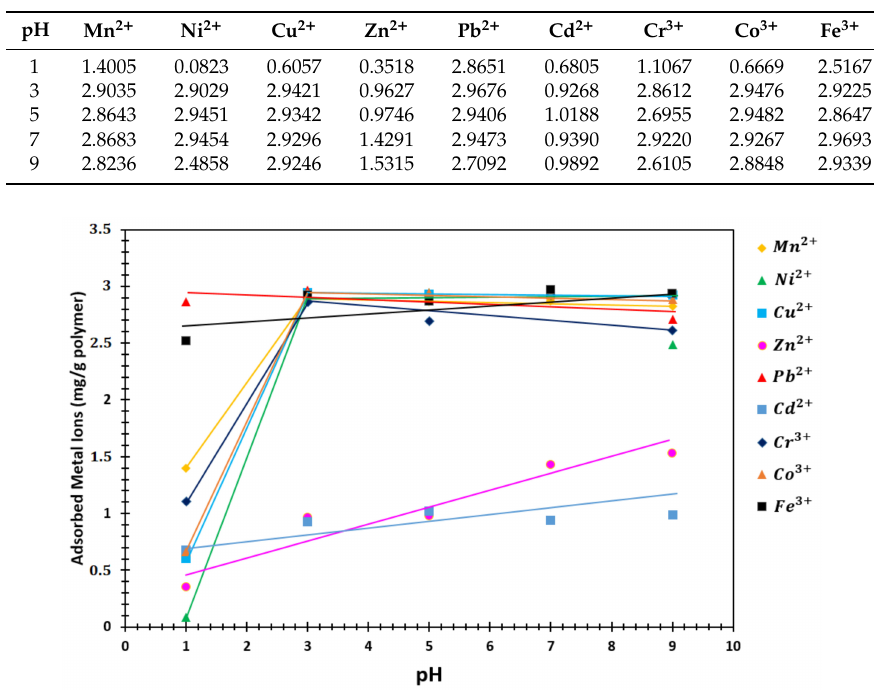
Figure 10. q graph against di ff erent pHs of the metal ion solutions (mg / g